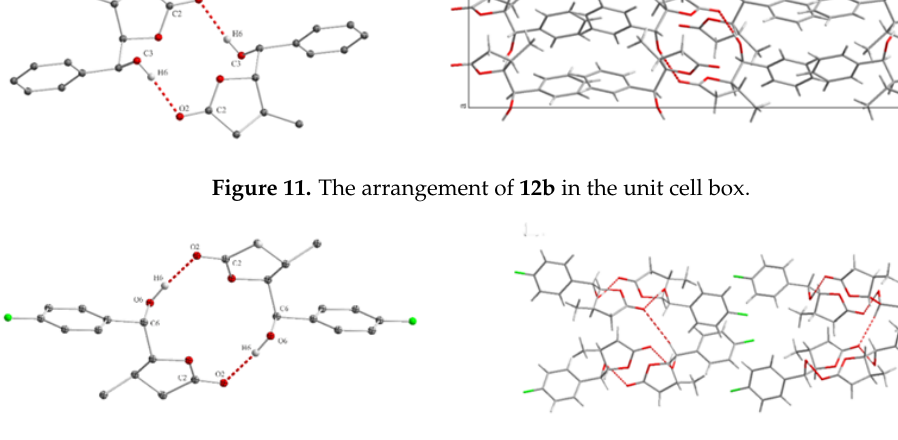
Figure 12. The arrangement of 12c in the unit cell